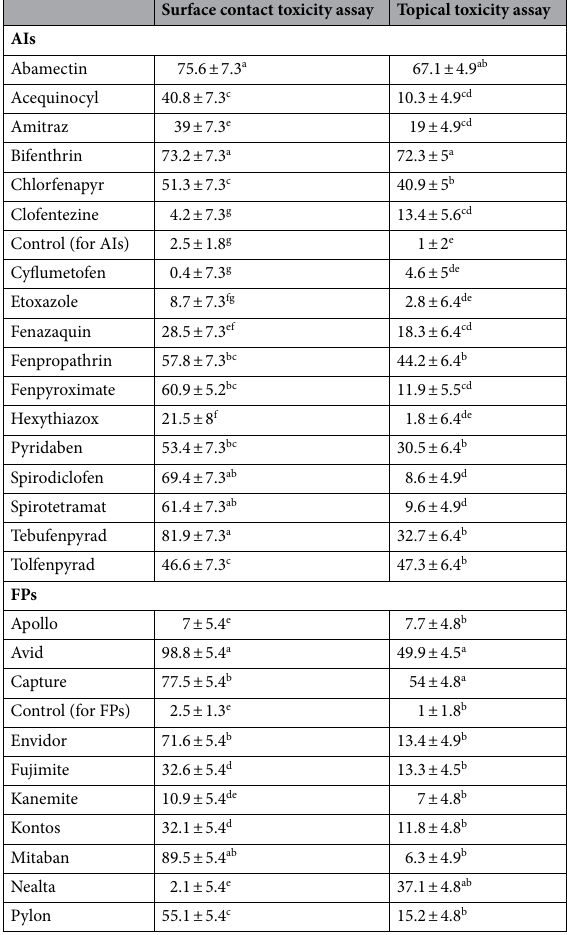
Table 1. Mean (± SE) cumulative bee mortality (%) during 24 h exposure to different dilutions of AIs (n = 17) or FPs (n = 10) in acute surface contact (Mason jar) or topical (micro-applicator) toxicity assays. Amitraz and Mitaban were tested as reference control for AIs and FPs, respectively. Means with the same letter in each column among AIs or FPs treatments are not significantly different ( p >